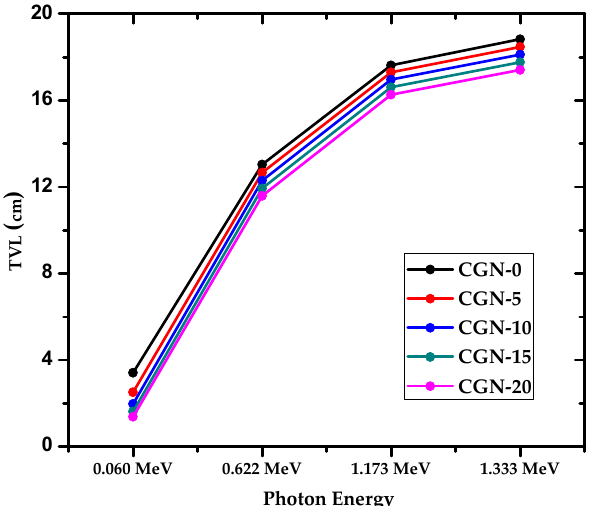
Figure 12. The TVL of prepared CGN-samples at different energies.